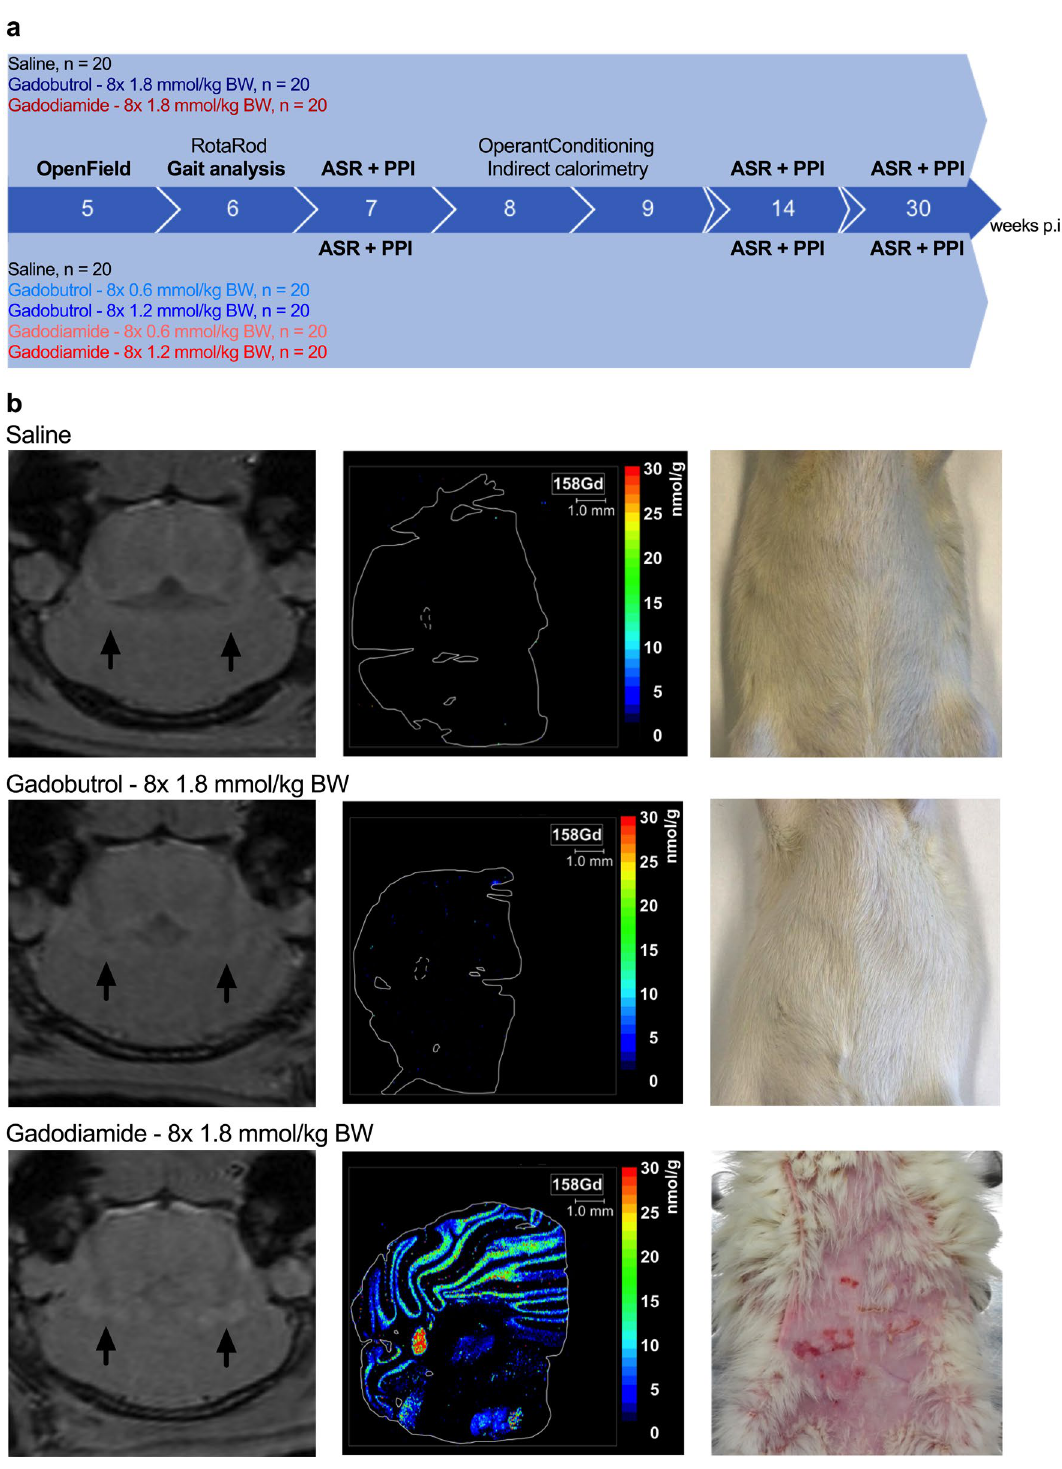
Figure 1. Comprehensive and longitudinal behavioral phenotyping after repeated administration of clinical doses of linear gadodiamide and macrocyclic gadobutrol in a rat model. ( a ) Experimental setup for longitudinal and comprehensive behavioral phenotyping from 5 to 30 weeks after the last injection showing time points of the behavioral tests. ( b ) Representative images from T1-weighted (T1w) MRI at 4.7 T in axial orientation 5 weeks p.i. Regions of interest in the lateral cerebellar nuclei are marked by arrows (left panel). Spatial distribution and quantification of Gd in the cerebellum at 11 weeks p.i. (middle panel). Macroscopic NSF-like skin lesions in gadodiamide rats observed until 12 weeks p.i. (right